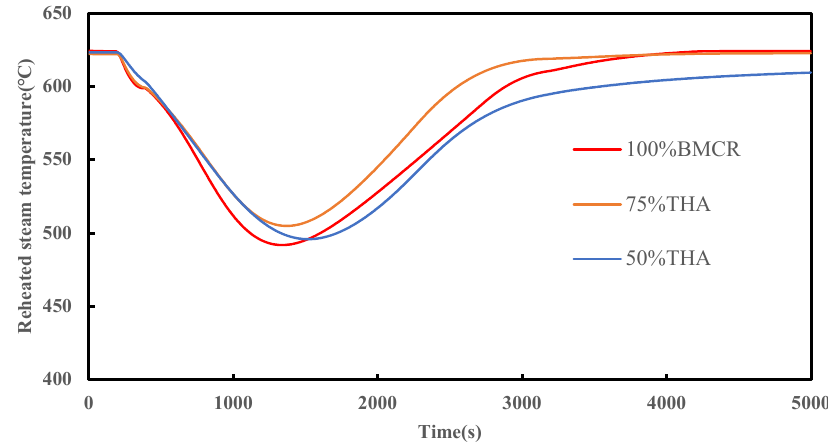
Figure 6. Response of reheated steam temperature during MFT at different conditions.